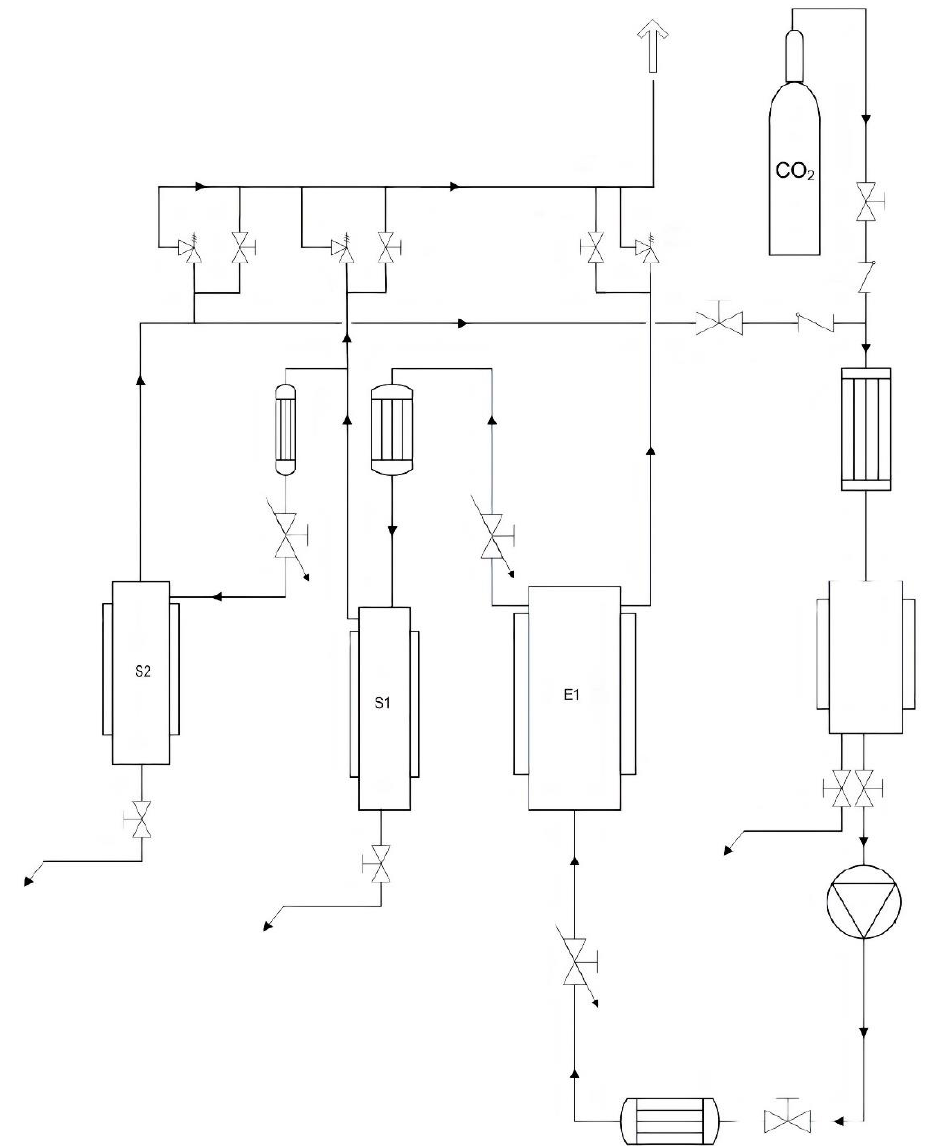
Figure 4. Scheme of the supercritical CO 2 extraction plant used for defatting lupin seed flour sam- ples.